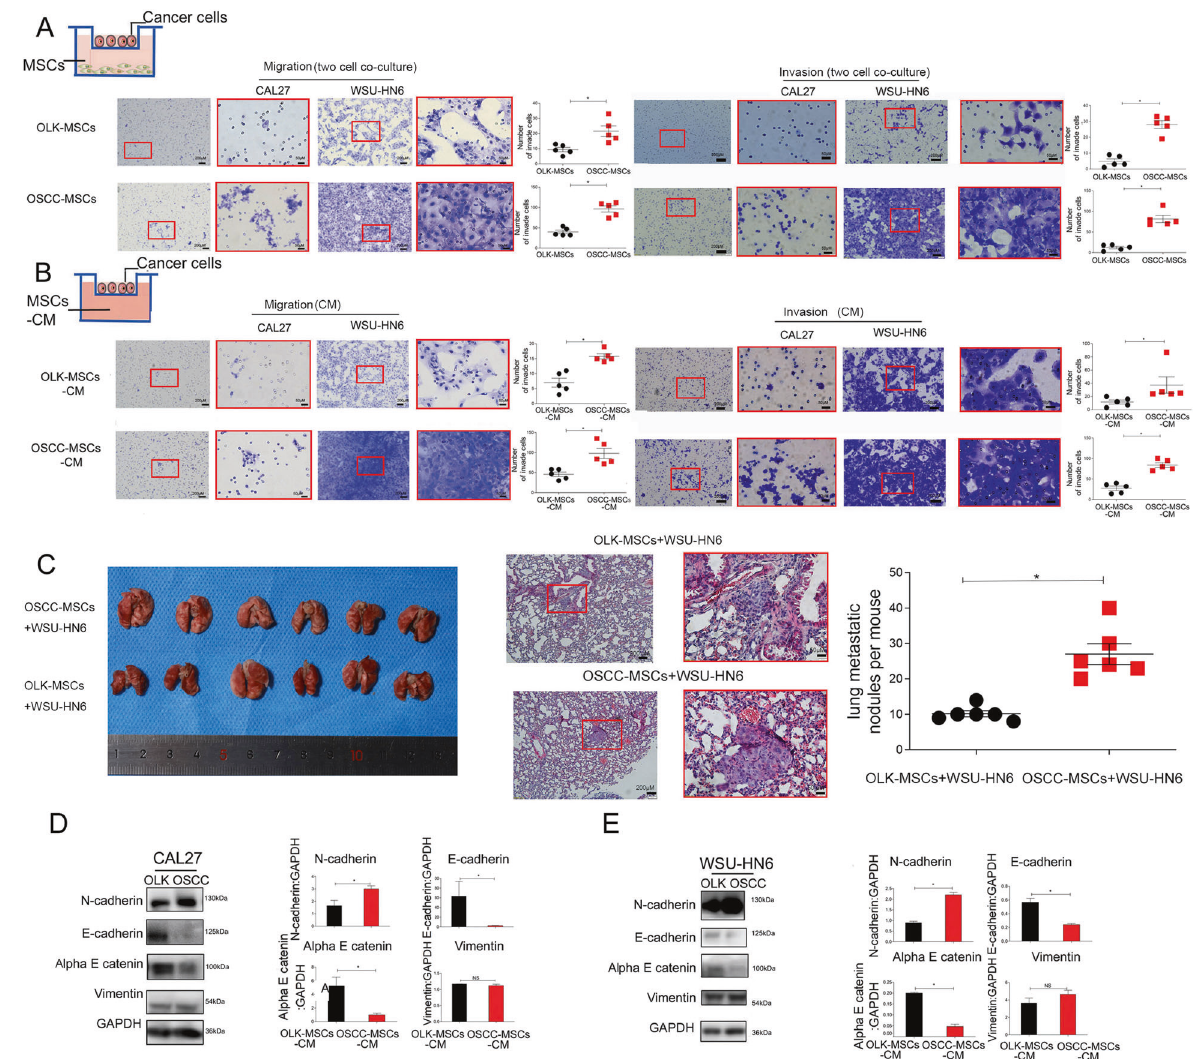
5). C OLK-MSCs or OSCC-MSCs (10 6 ) were co-injected WSU-HN6 (10 6 ) into BALB/c mice via tail vein ( n = 6). Metastasis lung tumor nodules were counted after 28 days. OSCC-MSCs promote the metastasis of CAL27 ( C ) and WSU-HN6 cells ( D ) through epithelial ‐ mesenchymal